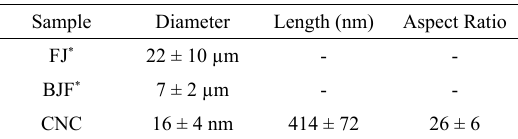
Figure 2. TEM image of dried dispersion of CNCs. Table 2. Diameter, length, and aspect ratio for raw jute fibers (JF), bleached jute fibers (BJF), and CNCs.